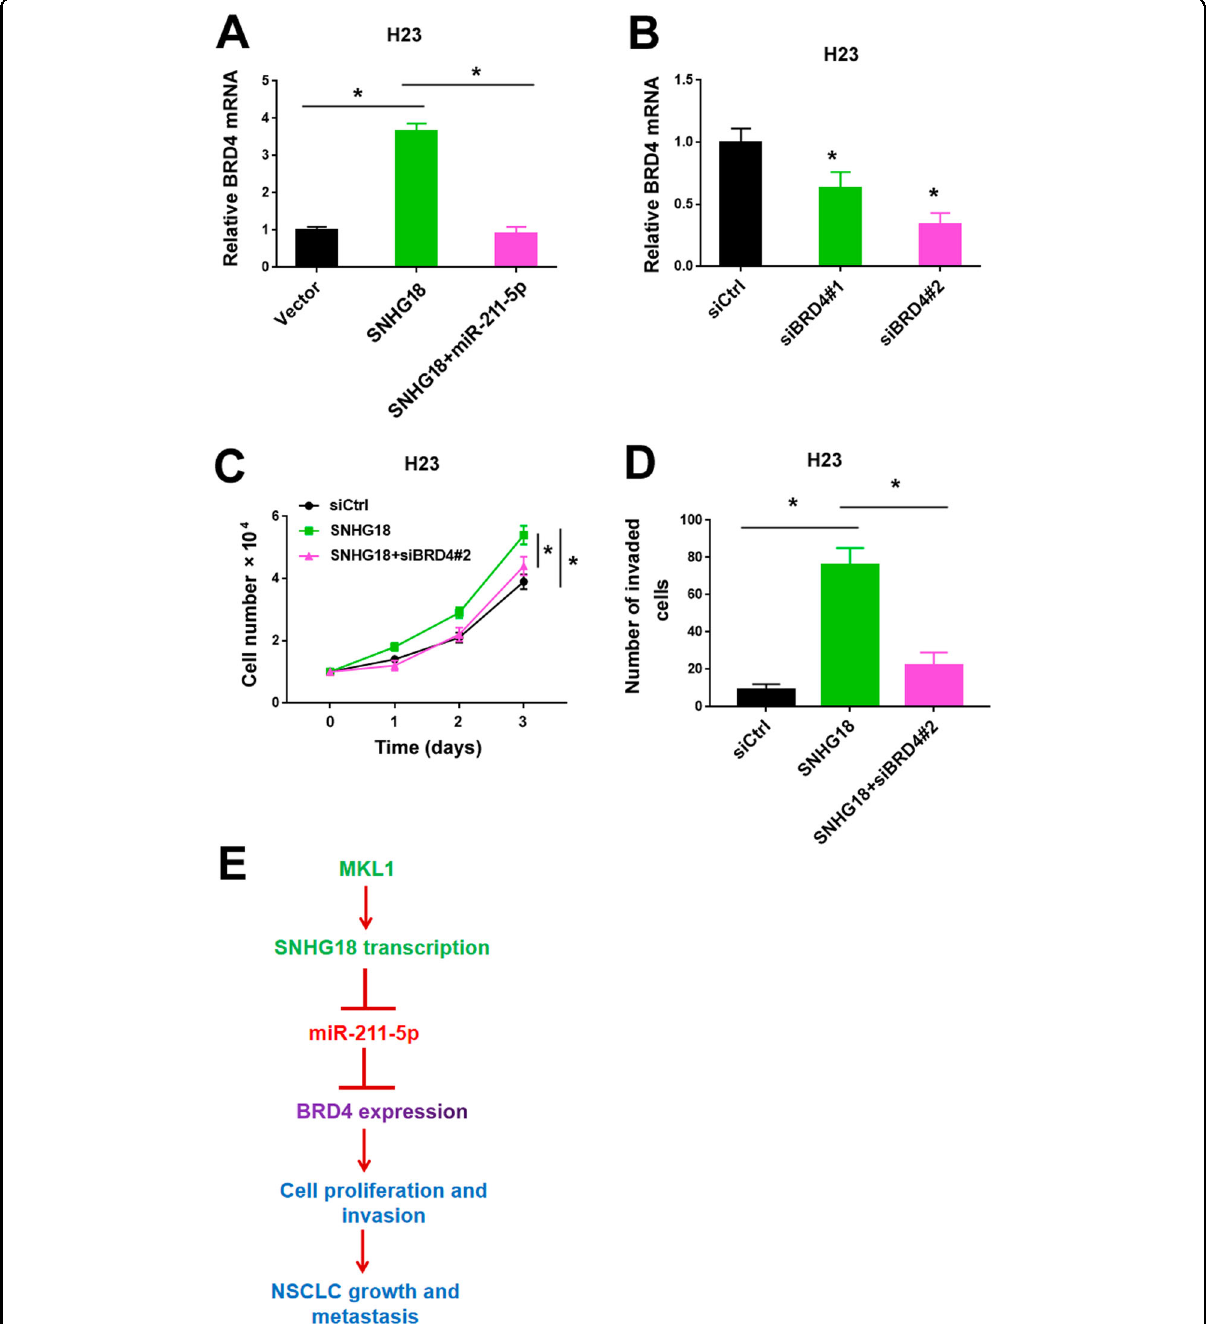
Fig. 8 Derepression of BRD4 contributes to SNHG18-mediated aggressive phenotype. A Quantitative PCR analysis of BRD4 mRNA in H23 cells transfected with indicated constructs. n = 3. B Quantitative PCR analysis of BRD4 mRNA in H23 cells transfected with control siRNA (siCtrl) or 2 different BRD4-targeting siRNAs (siBRD4#1 and siBRD4#2). n = 3. C , D Assessment of C cell proliferation ( n = 4) and D invasion ( n = 3) in H23 cells transfected with indicated constructs. In all panels in this fi gure, one-way ANOVA and Bonferroni ’ s tests were performed. * P < 0.05. E Schematic diagram of the molecular mechanism by which MKL1-induced SNHG18 promotes NSCLC growth and metastasis through the miR-211-5p/BRD4 pathway.